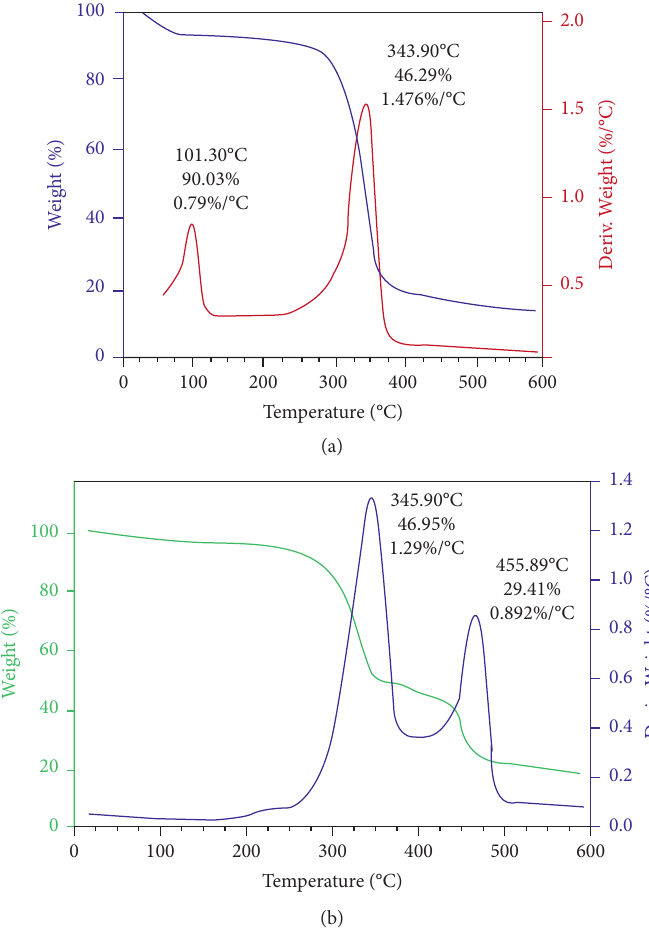
Figure 4: TGA thermogram of (a) bare cotton fibers and (b) polyaniline-deposited cotton